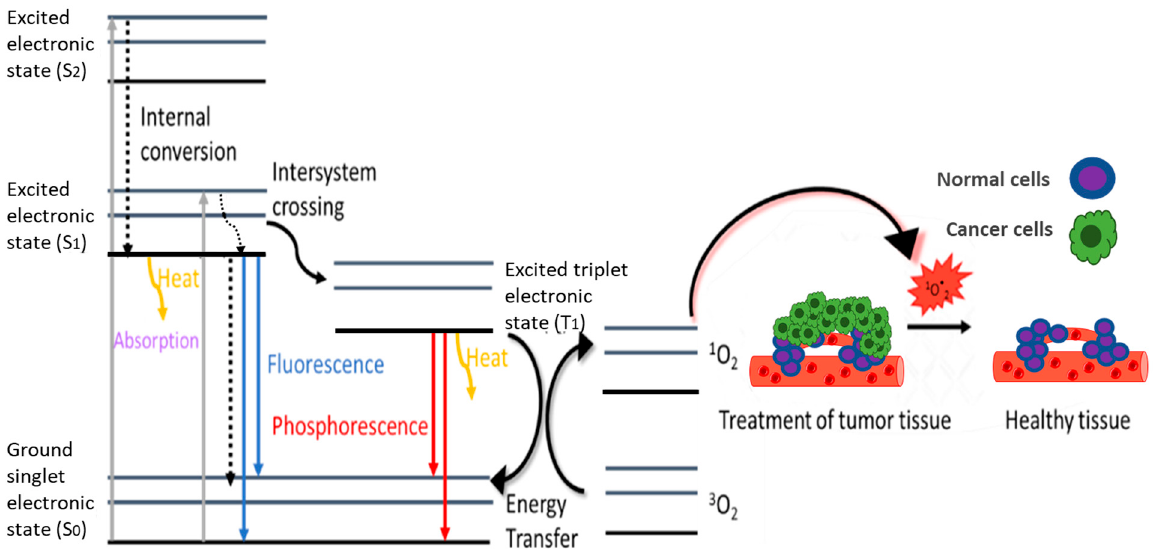
Figure 6. This figure presents a Jablonski diagram showing the basic processes that can take place when a molecule with absorption capacity is irradiated by a suitable wavelength of radiation. It also presents the basic principle of PDT and how it destroys the cancer cells of a tissue (green cells are